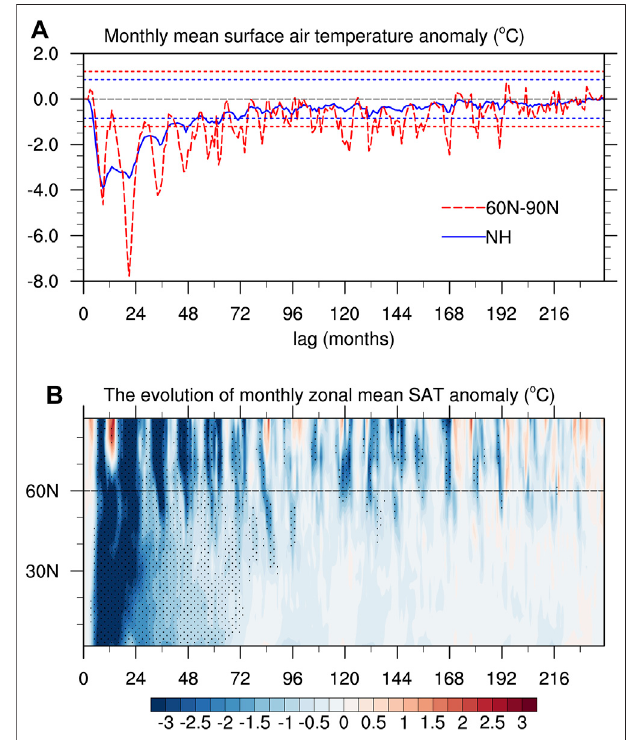
FIGURE 1 | (A) Time series of monthly mean surface air temperature (SAT) anomaly over NH (blue solid line) and Arctic (60 ° N – 90 ° N, red dashed line). The blue and red horizontal dots lines in (A) indicate the standard deviation of SAT over the NH and Arctic, respectively. (B) The evolution of monthly zonal mean SAT anomaly over NH. The dots in (B) denote areas with con fi dence exceeding the 90% level. Lag (0) represents the January of the eruption